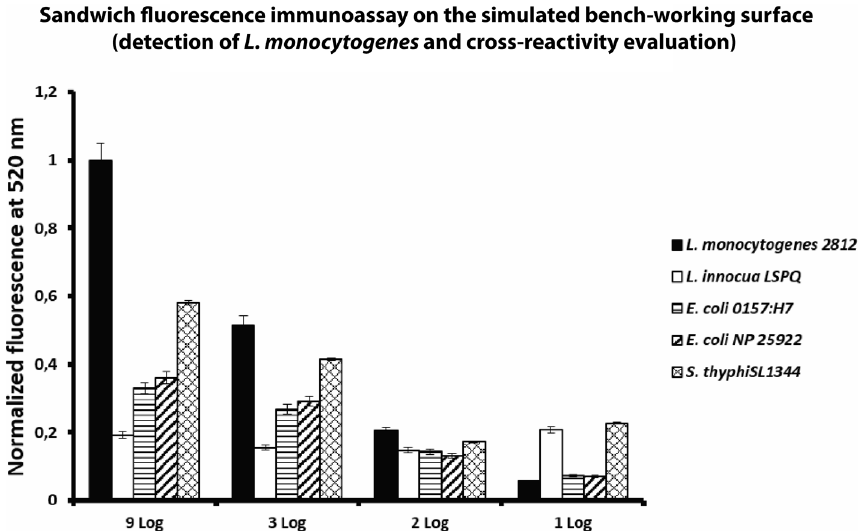
Figure 6. Sandwich fluorescence immunoassay on the simulated bench-working surface (detection of LM and cross-reactivity evaluation). Sandwich fluorescence immunoassay: four dilutions were been tested (9 Log, 3 Log, 2 Log and 1 Log) of five different bacteria strains. The developed assay shows a LOD value of 2